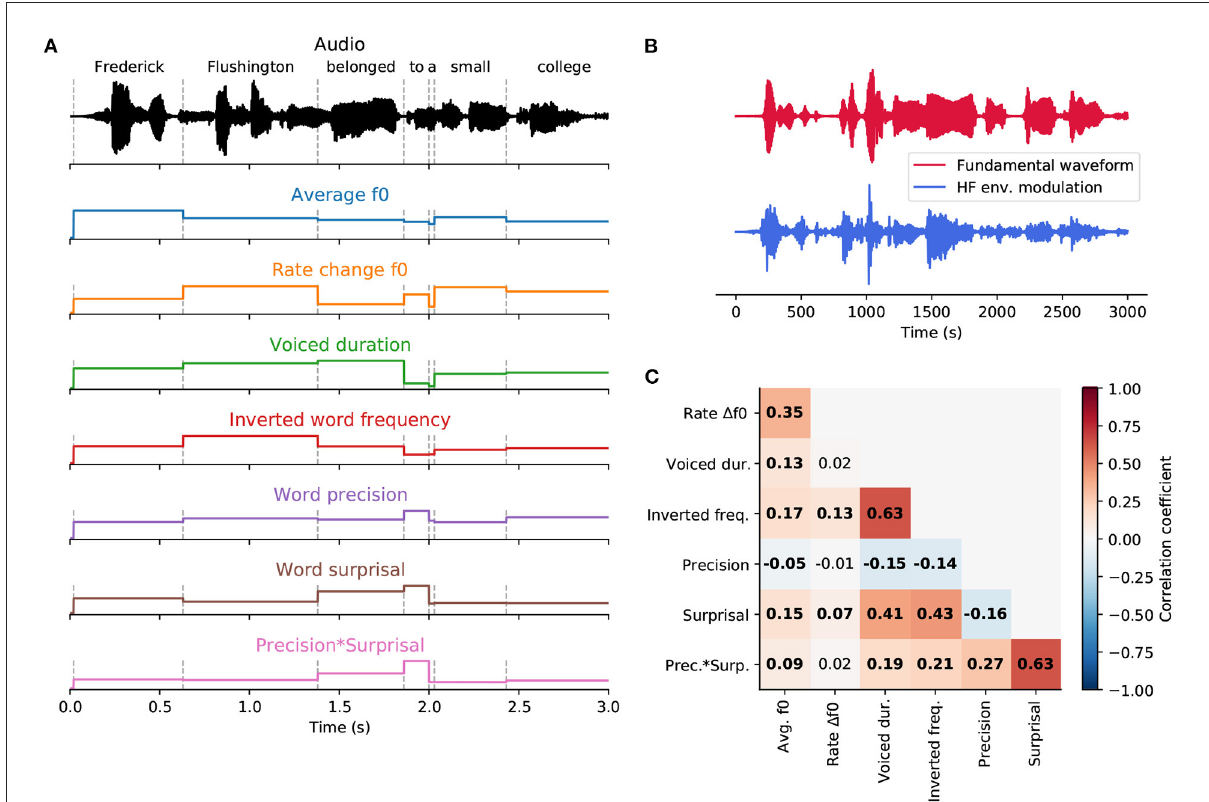
FIGURE2 Word-level features. (A) , An exemplary part of a speech signal (black). Dashed vertical lines represent word onsets. Seven features (colored) were used to describe each word in the stories presented to the participants. Three of them—the averaged fundamental frequency (f0), the rate of f0 change and the duration of the voiced part—were acoustic features based on the voiced parts of each word. The remaining four features—inverted word frequency, word surprisal, word precision and the interaction of precision and surprisal—were derived from a language model and characterized linguistic properties of each word. (B) , The two stimulus features extracted from the exemplary audio segment, the fundamental waveform (red) and the high-frequency (HF) envelope modulation (blue). (C) , Pairwise correlations between word-level features. Significant correlations ( p < 0.05 , after correcting for multiple comparisons using the Benjamini-Yekutieli method) are denoted in